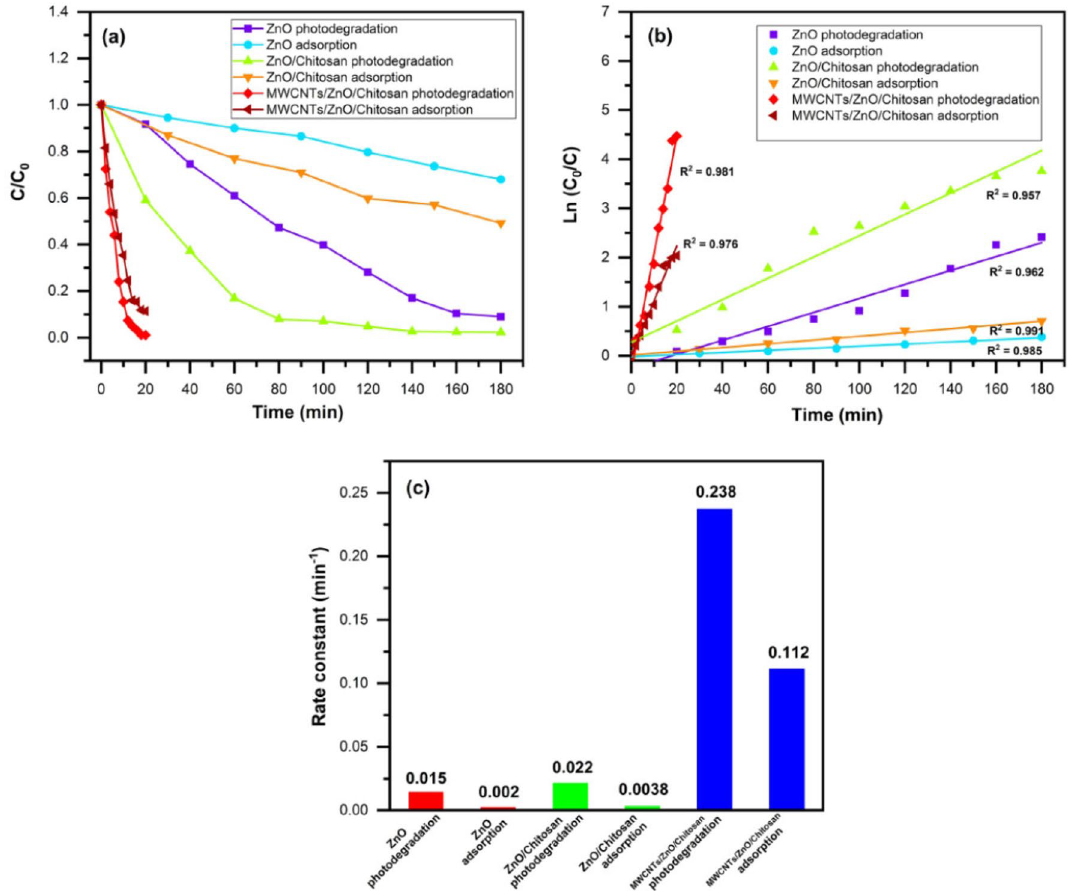
Figure 13. ( a ) photocatalytic degradation and adsorption effectiveness of MB by synthesized samples under UV light and dark conditions, ( b ) the matching kinetic analysis of MB degradation and MB adsorption, ( c ) the kinetic constant of MB degradation as well as MB adsorption by synthesized samples under UV light and dark